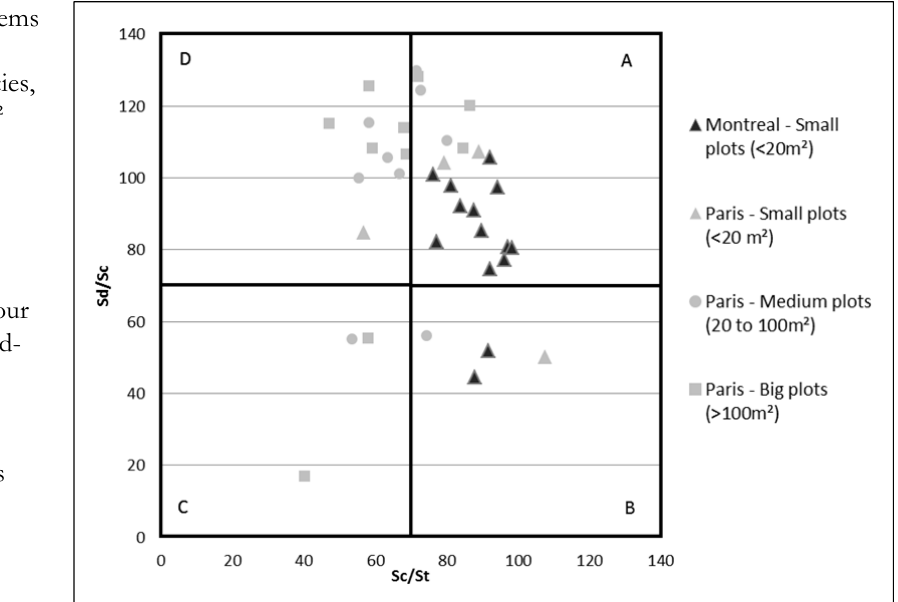
Figure 11. Four Classes of Gardeners According to Their Use of Land for Food Production (Paris, n =23, average for 2012–2013; Montreal, n =14, 2013) Legend: A. Highly intensive use of the plot for food crops; B. Plot mainly dedicated to food crops but low intensity in the use of space; C. Non-intensive use of the plot, with priority to uses other than food production; D. Highly intensive use of the cultivated area for food crops but other uses of the garden as